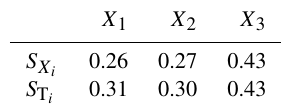
Table 1. The sensitivity indices for the simple model Y = X 1 · X 2 + X 3 . The indices for X 1 and X 2 are similar as they both have the same normalized variance. X 1 · X 2 creates additional variance by the interaction of the two parameters yielding higher total indices. X 1 X 2 X 3 S X 0.26 0.27 0.43 i S T 0.31 0.30 0.43 i